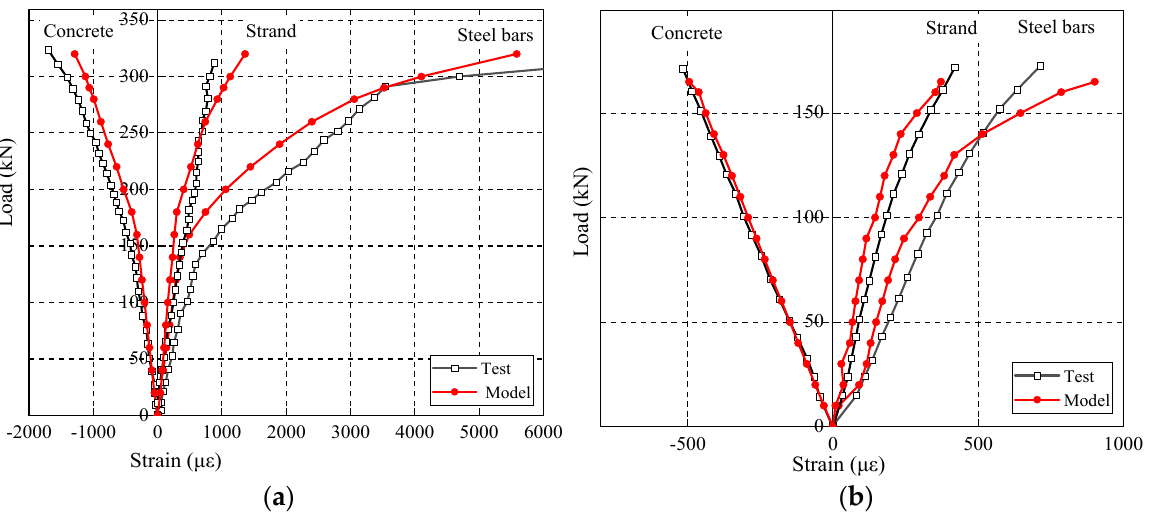
Figure 23. Finite element simulation results: ( a ) Load-strain curves of the S1 beam under static loading; ( b ) Load-strain curve of the C3 beam under fatigue loading.